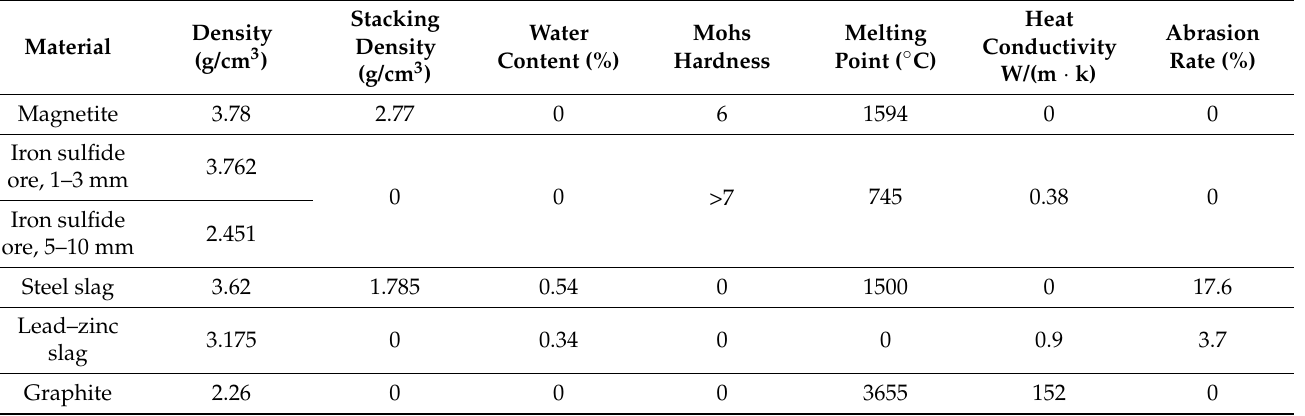
Figure 1. Microwave-absorbing materials used in the test: ( a ) magnetite; ( b ) 1–3 cm iron sulfide slag; ( c ) 5–10 cm iron sulfide slag; ( d ) steel slag; ( e ) lead–zinc slag; ( f ) graphite powder. Table 4. Basic properties of the microwave-absorbing materials (Table 4 shows the technical param- eters of the raw materials, provided by the material purchase manufacturers, which are not part of the current study).